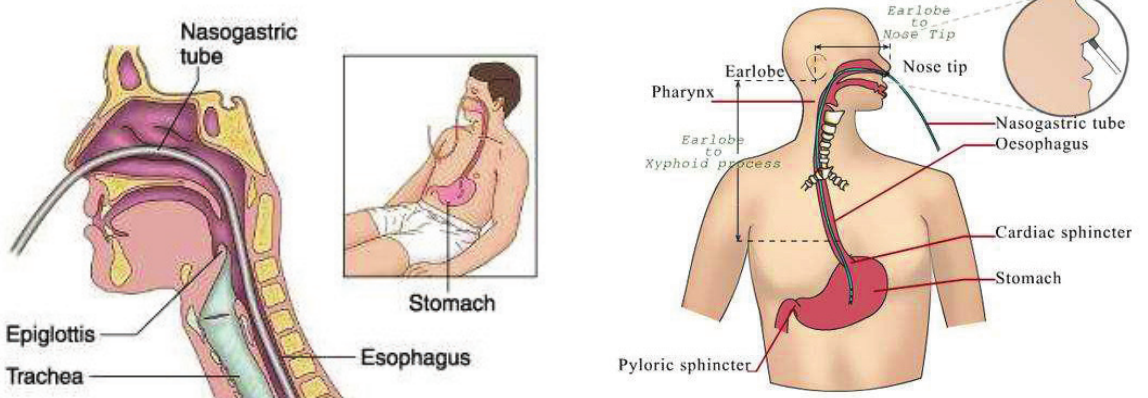
Figure 1: Left, nasogastric feeding route; Right, is gastrointestinal double lumen tube fed the intestinal tract.